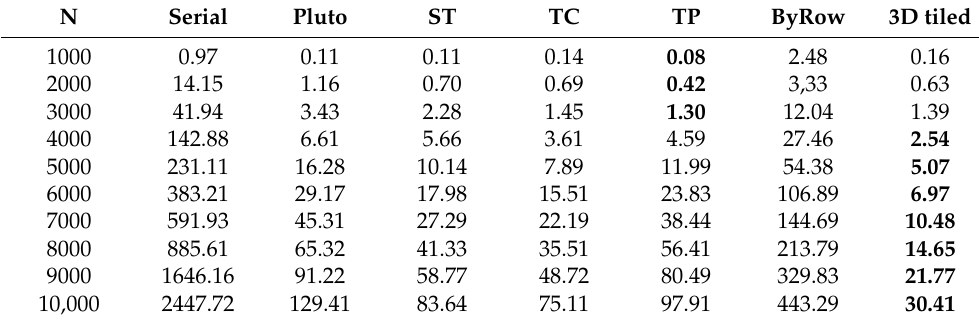
Table 5. Time in seconds for Intel Xeon E5-2699 v3 and 36 threads (ST, TC, and TP de-